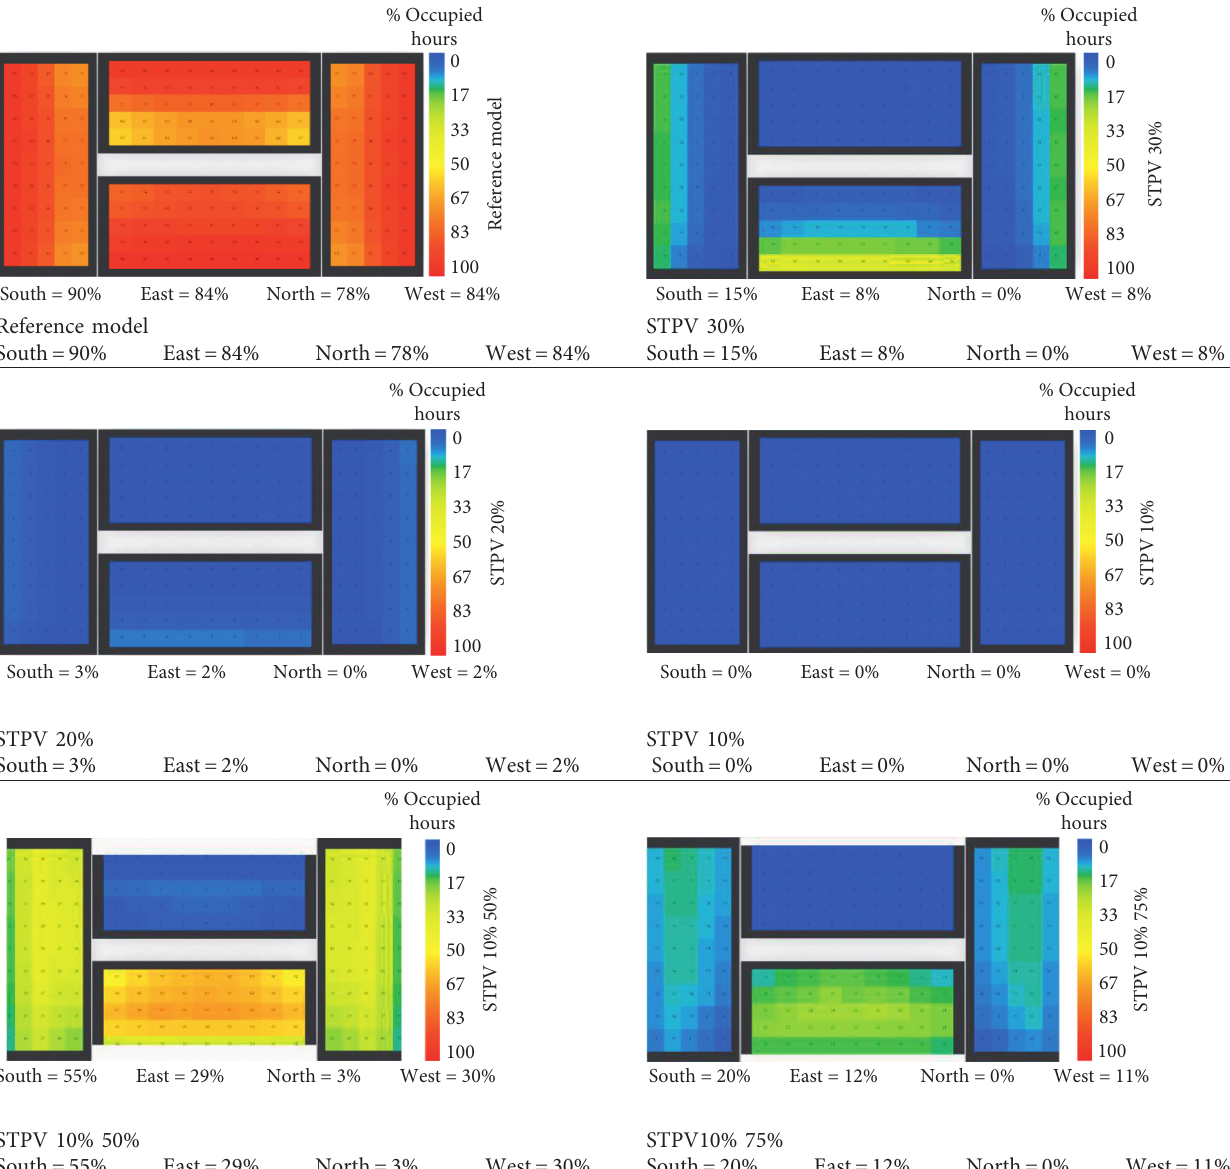
Table 10: DA300 lux distribution of fully glazed open office in cardinal orientations